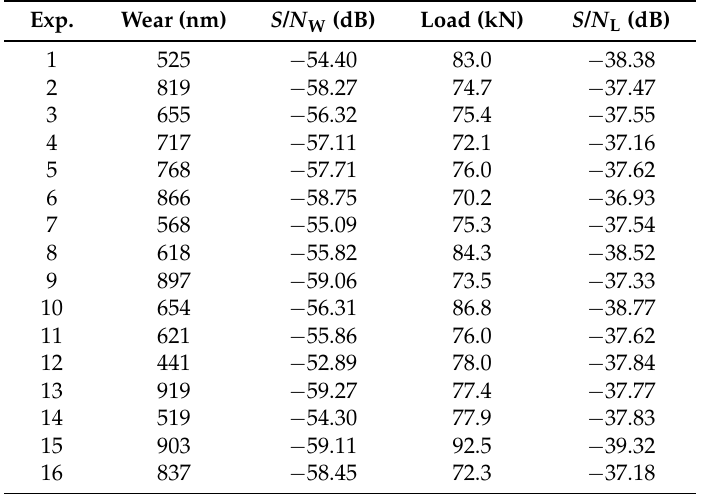
Table 3. S / N ratios and minimum loads of the third upper punch using the Taguchi method.